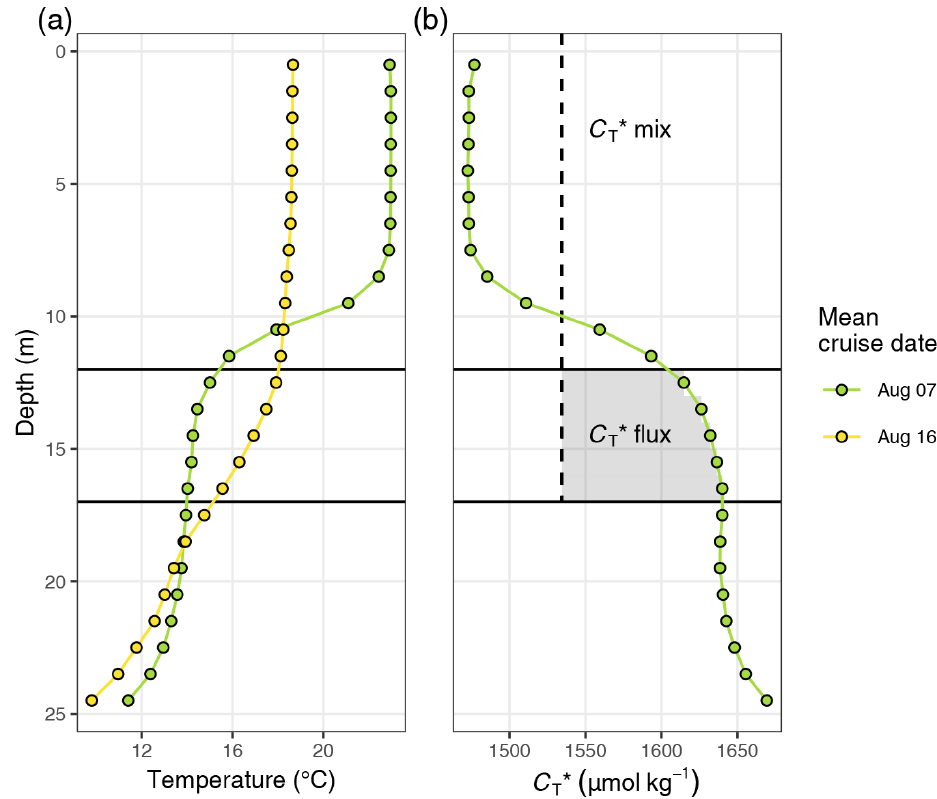
Figure C2. Illustration of the approximation of the entrainment flux of C ∗ layer from 12 to 17m water depth between 7 and 16 August is based on the observed changes in the temperature profiles. (b) Assuming a complete, instantaneous mixing of the water column after 7 August, the hypothetical homogeneous concentration of C ∗ used to approximate the entrainment flux of C ∗